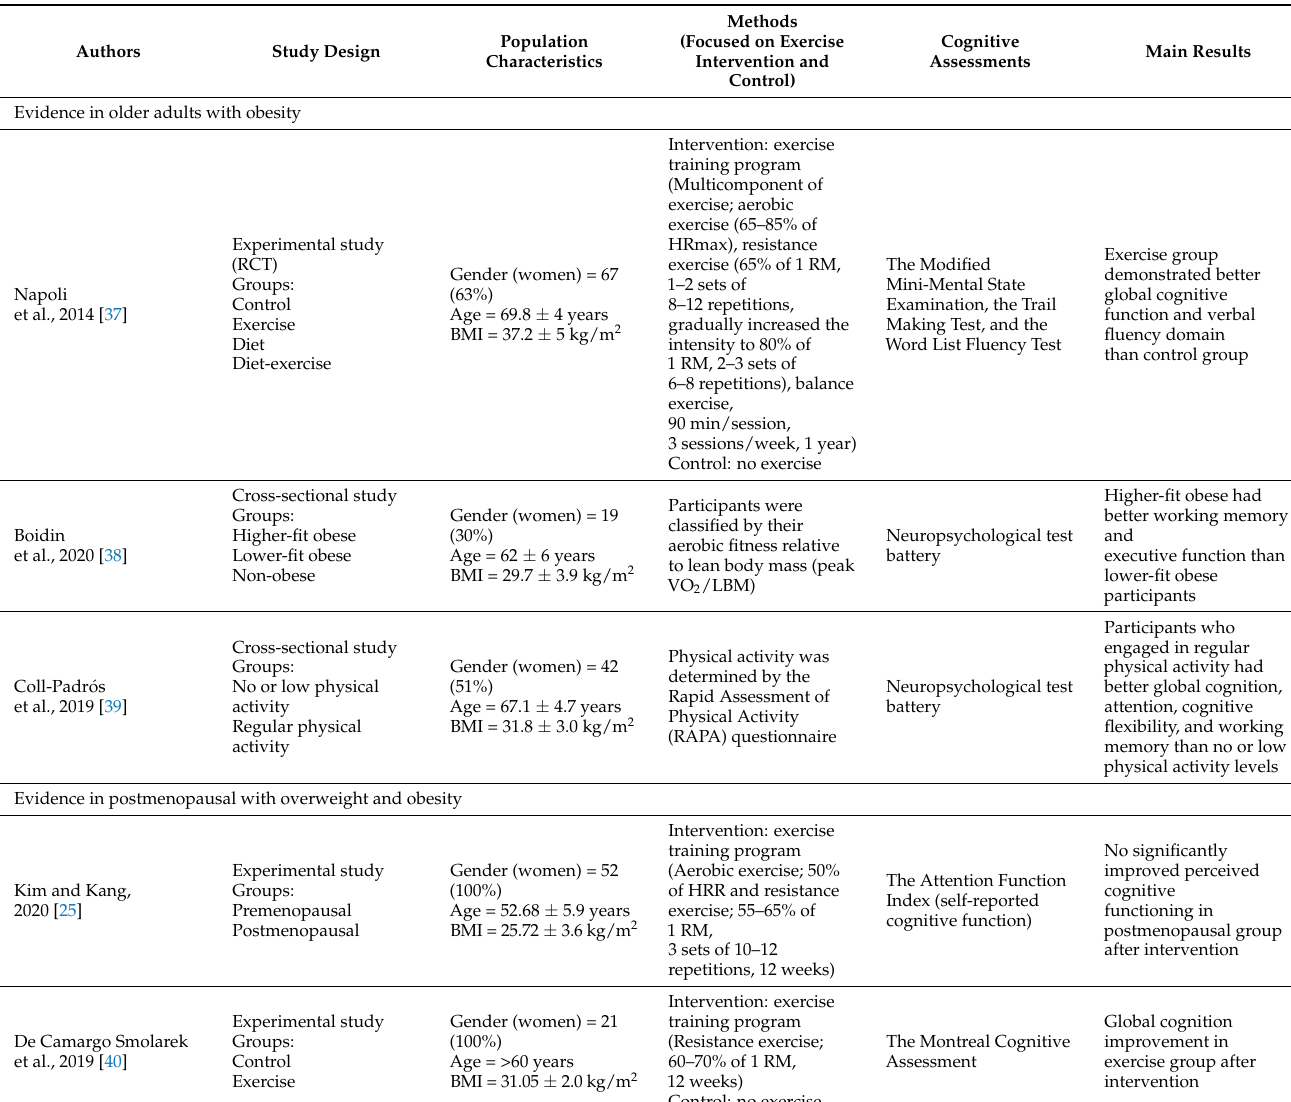
Table 1. Studies investigating the effects of physical exercise on cognitive